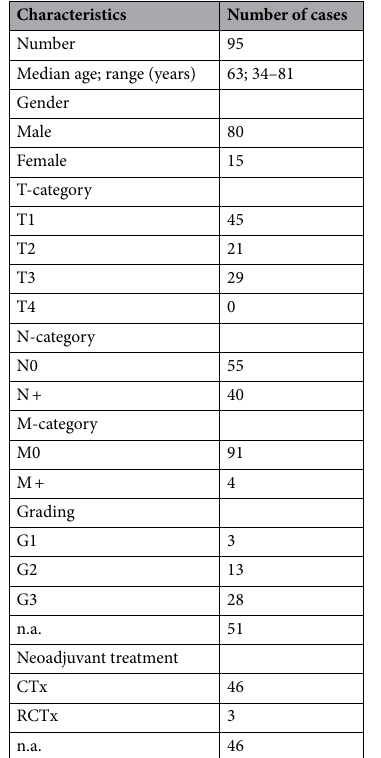
Table 2. Clinico-pathological patient’s characteristics. n.a. – not applicable; CTx – chemotherapy; RCTx—